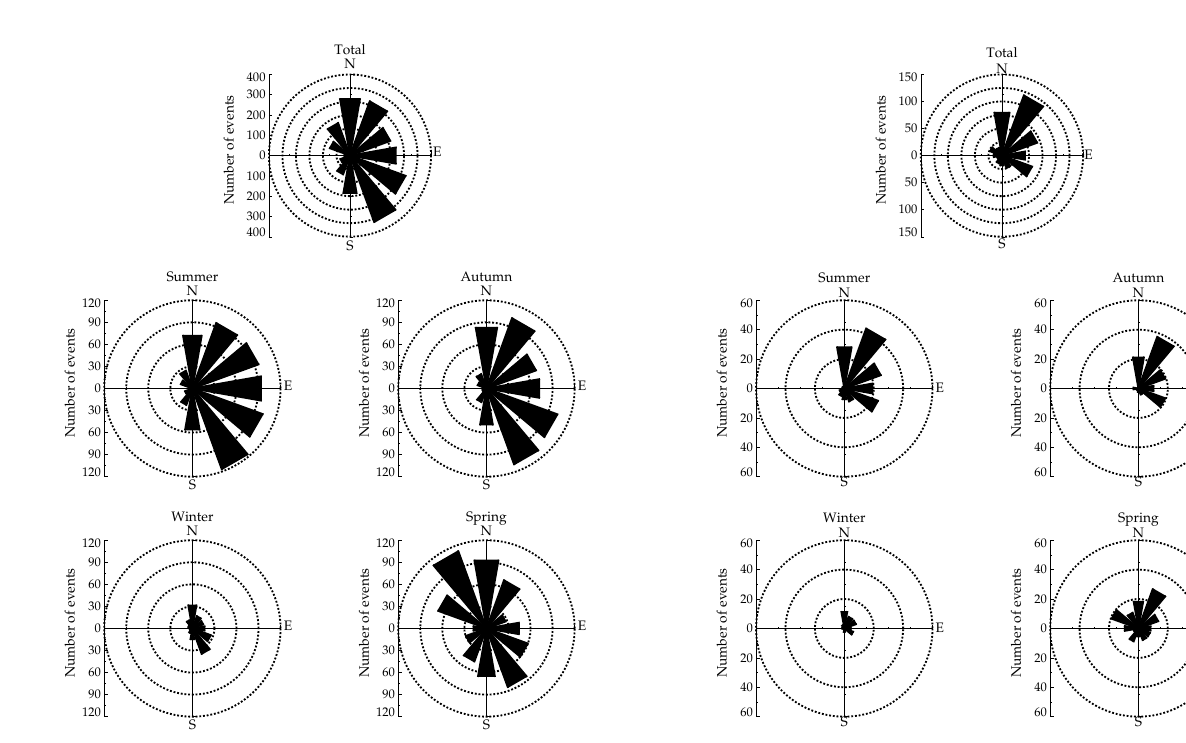
Figure 5. The number of SSGW events versus the propagation di- rection for all 11 years of AGW observations (each bin has 30 ◦ ).